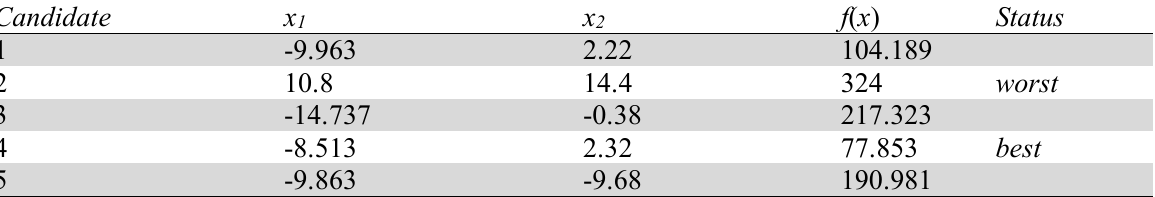
Updated values of the variables and the objective function based on fitness comparison at the end of second iteration